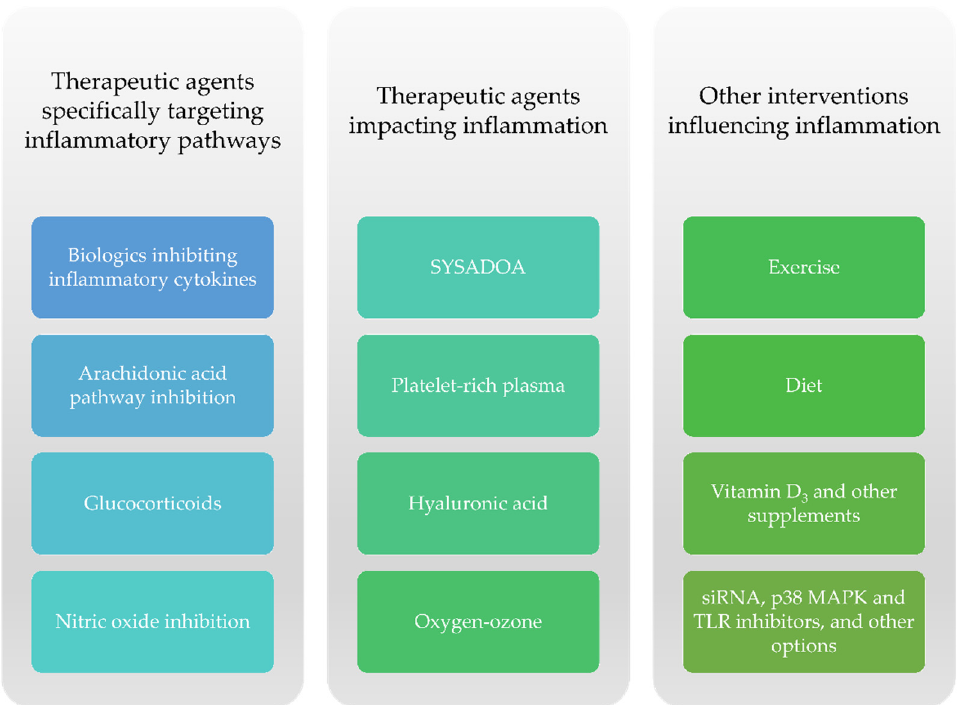
Figure 5. Drugs, dietary supplements, and other interventions contributing to a reduction in in- flammation in knee